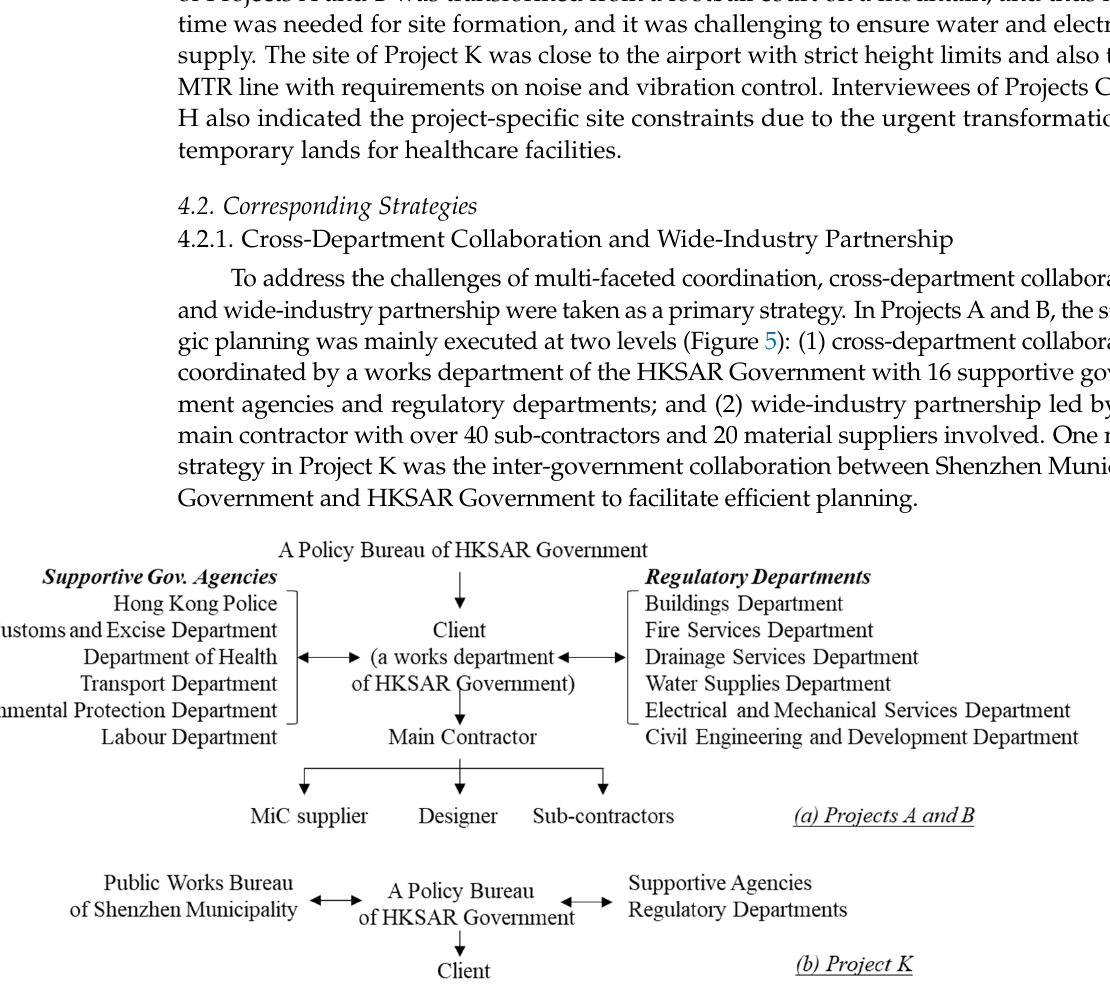
Figure 5. Inter-government and cross-department collaboration.